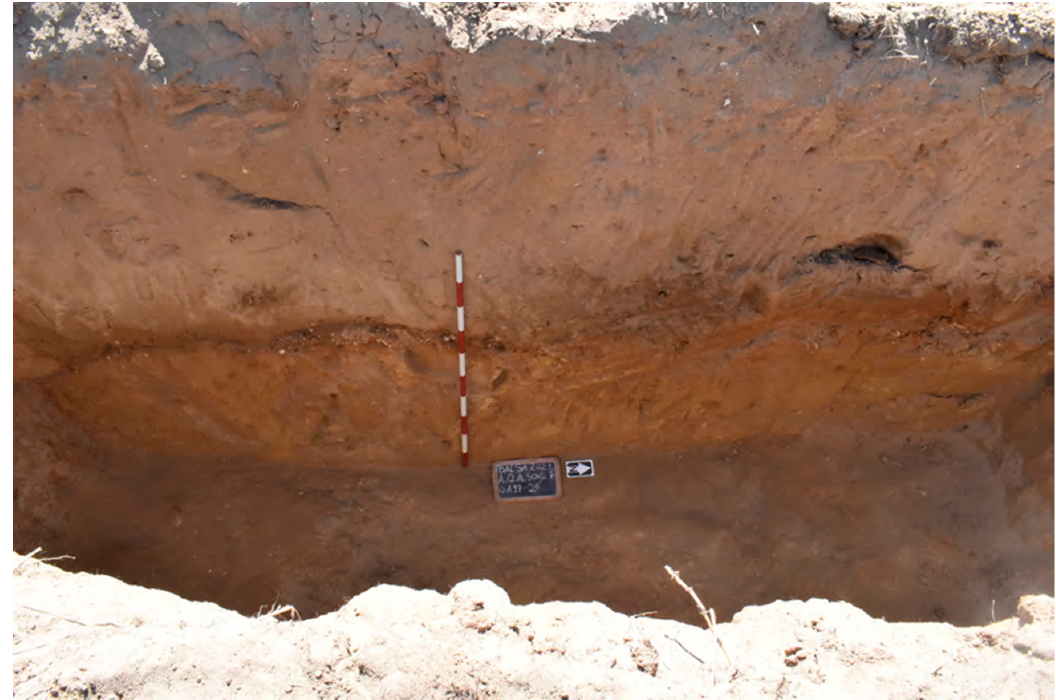
Figure 14. Sounding opened in P1-2. In this case, the geophysical alterations were caused by the diverse nature of the sediments.